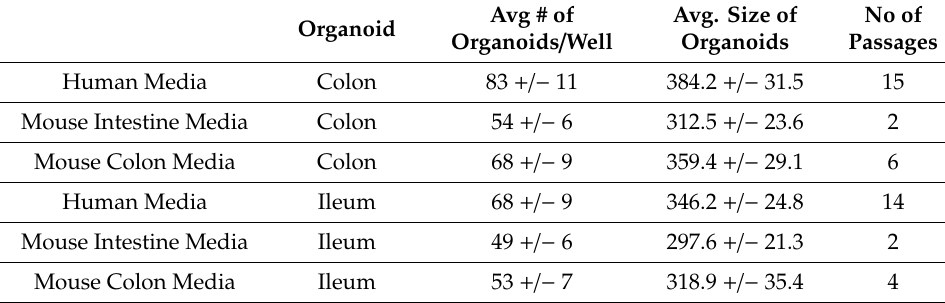
Table 3. Optimization of feline ileum and colon culturing conditions. The number and size of organoids were measured 10 days post-splitting for every other